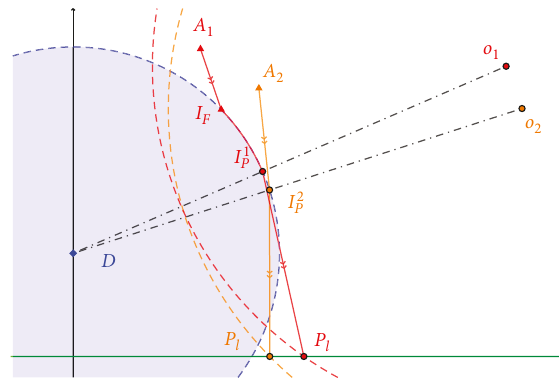
Figure 6: The positions of I 1